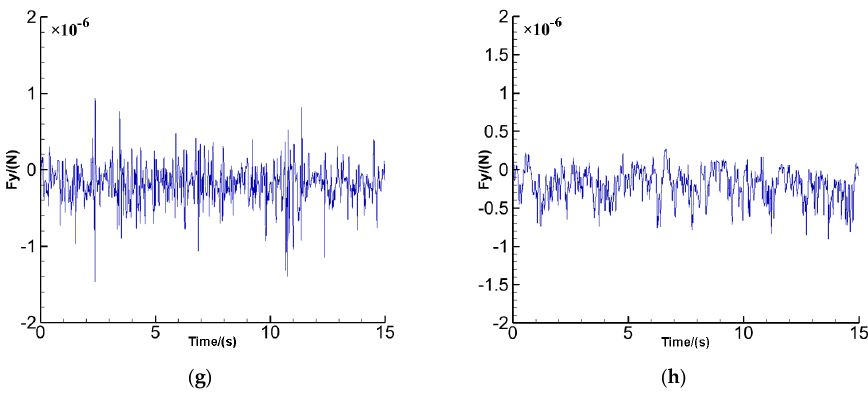
Figure 14. Timelines of F y ( a ) Sensor 1; ( b ) Sensor 2; ( c ) Sensor 3; ( d ) Sensor 4; ( e ) Sensor 5; ( f ) Sensor 6; ( g ) Sensor 7; ( h ) Sensor